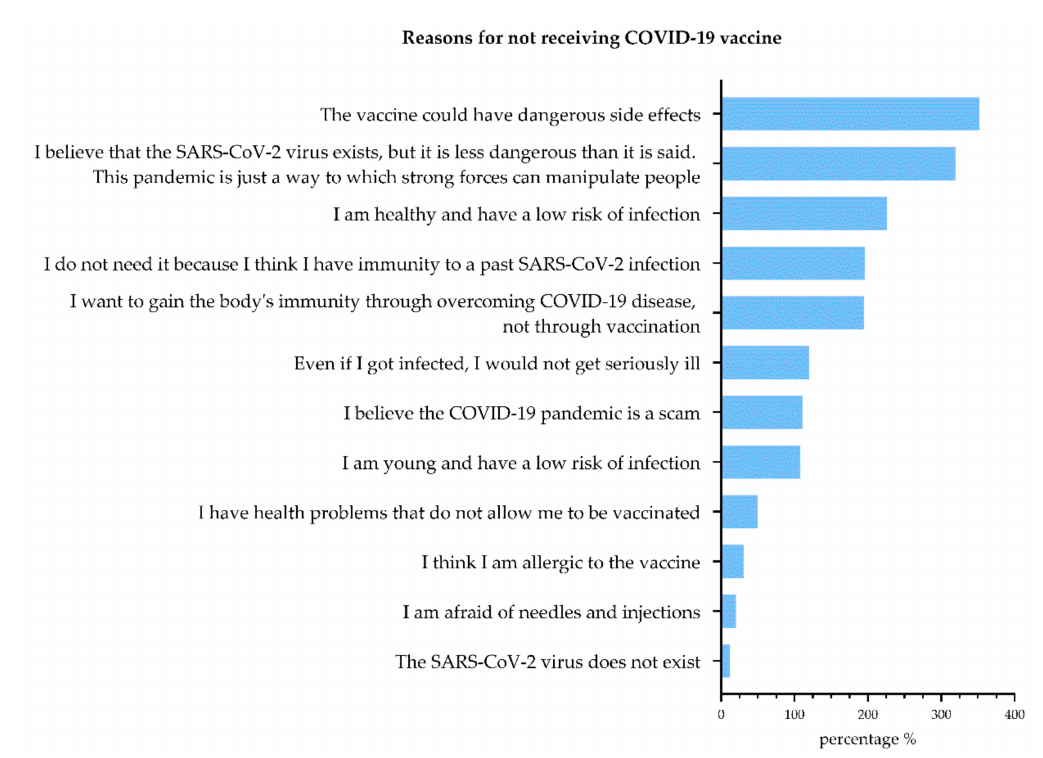
Figure 1. Reason for receiving or not receiving booster dose among vaccinated participants.